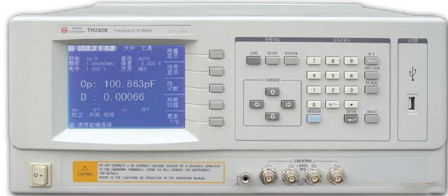
Figure 5. Model TH2828A of LCR digital bridge.